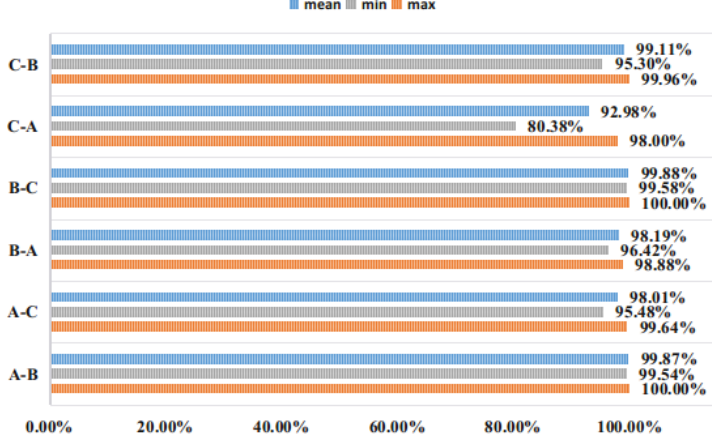
Figure 10. Drive end data test.